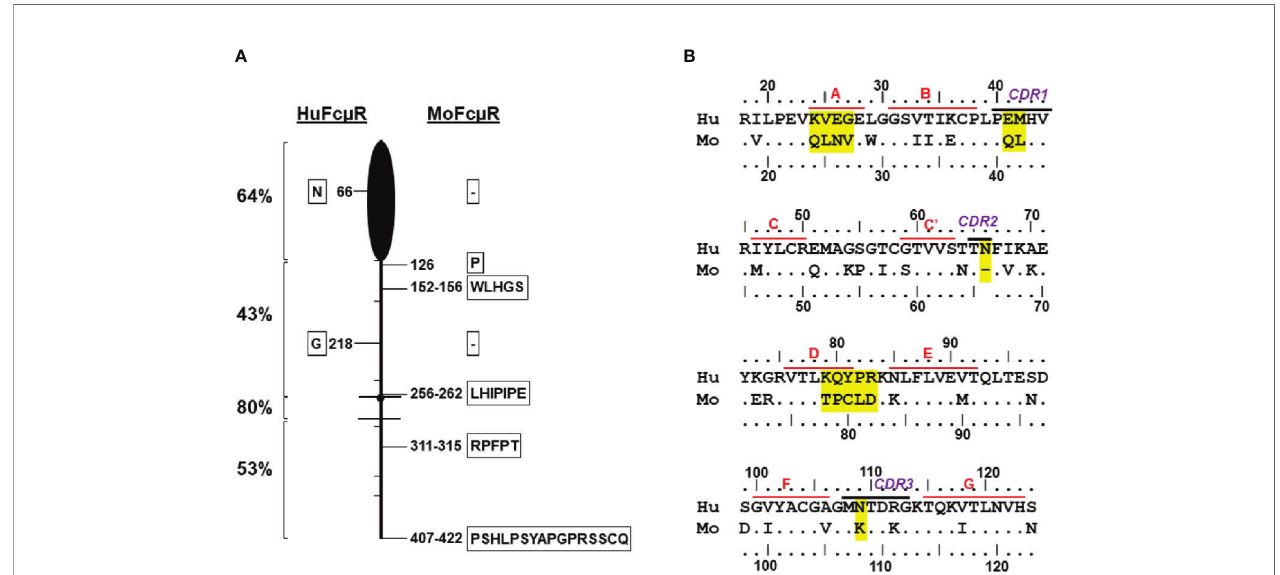
FIGURE 1 | Human versus mouse FcµR. (A) Schematic presentation of homology between human and mouse FcµRs. FcµR is depicted as a badminton-like shape consisting of amino-terminal Ig-like domain (black closed oval shape), stalk region (above the top line), transmembrane (between the two lines) and the cytoplasmic tail (below the bottom line). Hatch marks indicate exon boundaries and small closed circle in the transmembrane region indicates a charged His residue. Left numbers indicate percent identity in the indicated regions between human and mouse receptors. The positions of aa addition (single letter code within frame) or gap (- within frame) between human (left) and mouse (right) FcµR are shown along the cartoon. (B) Amino acid sequence alignment of the Ig-like domains of human and mouse FcµRs. The numbers indicate the aa position from the fi rst M residue of human and mouse FcµR on the top and bottom of the sequence, respectively. Amino acid identity is indicated by dots ( (cid:129) ) and gaps by dashes (-). Predicted ß-strands and complementary determining regions (CDRs) of human FcµR are indicated. Accession numbers of human and mouse FcµRs in NCBI are NM_005449 and NM_026976,